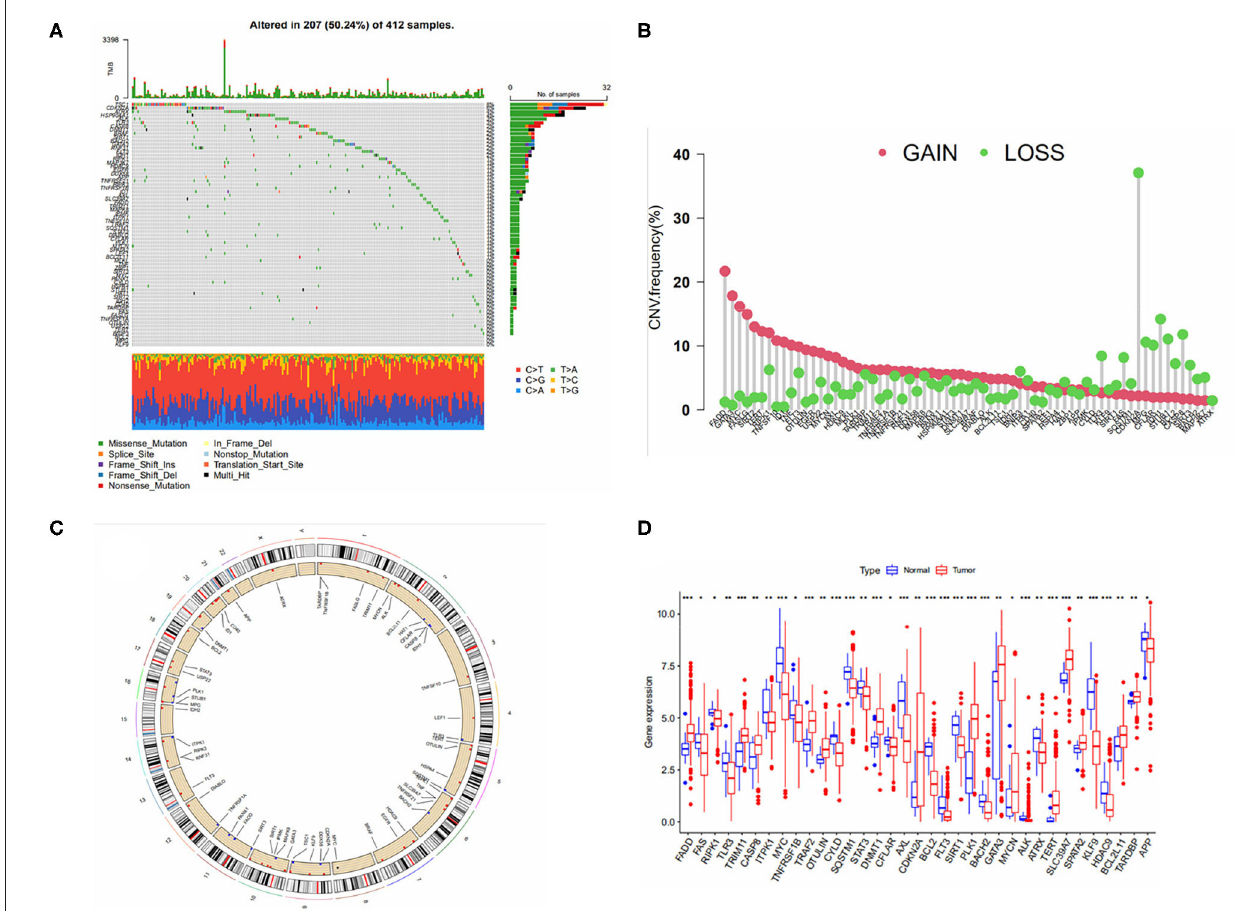
FIGURE 1 | (A) Mutation frequency of 67 necroptosis -related genes in 412 bladder cancer patients from the TCGA cohort. (B) Frequencies of CNV gain, loss, and non-CNV among NRGs. (C) Location of CNV in NRGS on 24 chromosomes. (D) Expression distributions of 67 NRGs between normal and tumor tissues.